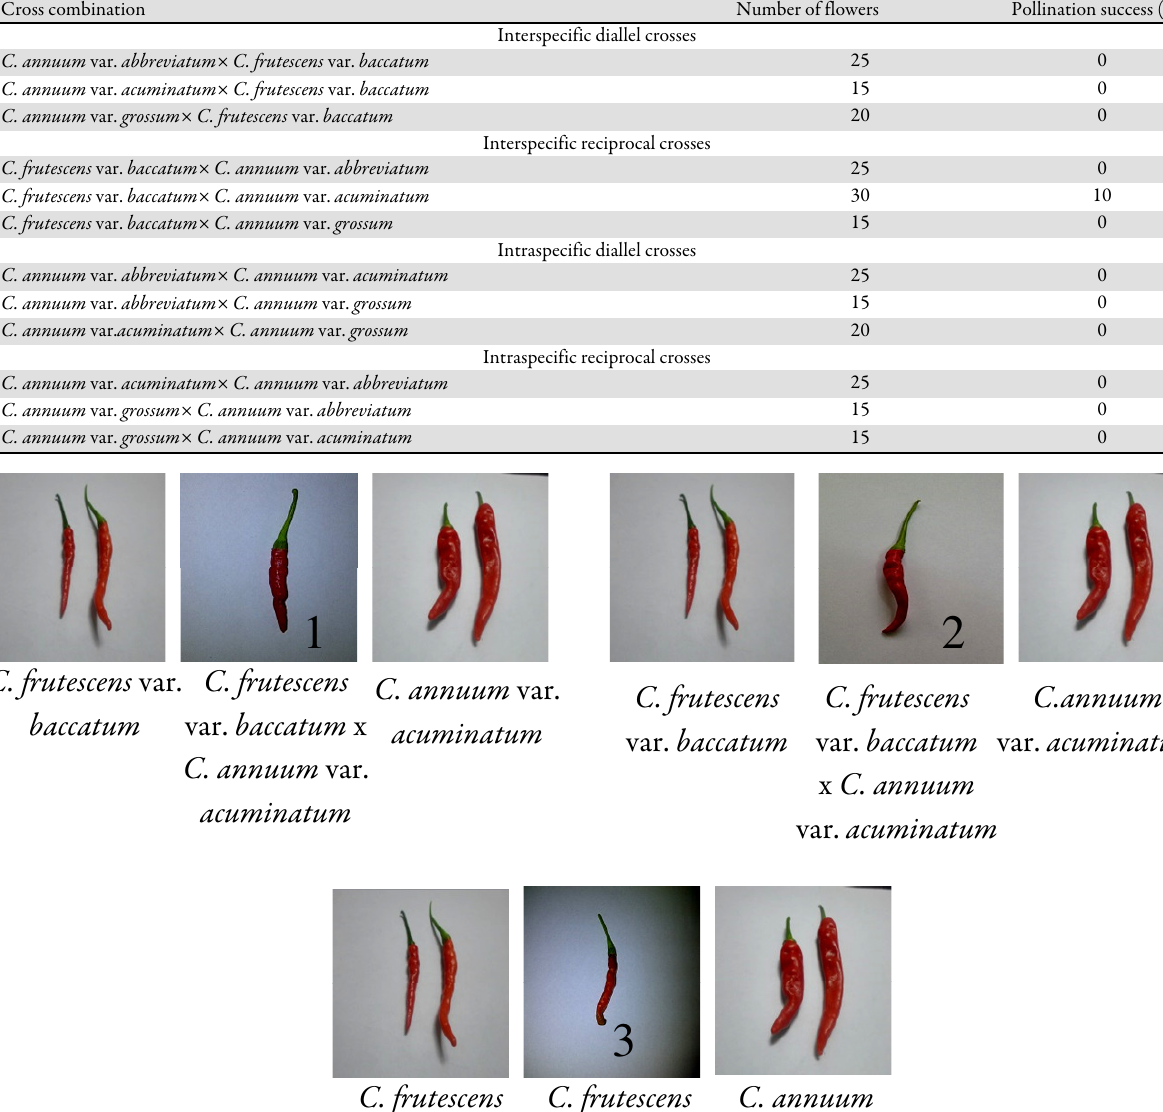
Table 3. Results of intraspecific and interspecific hybridization of the studied Capsicum varieties